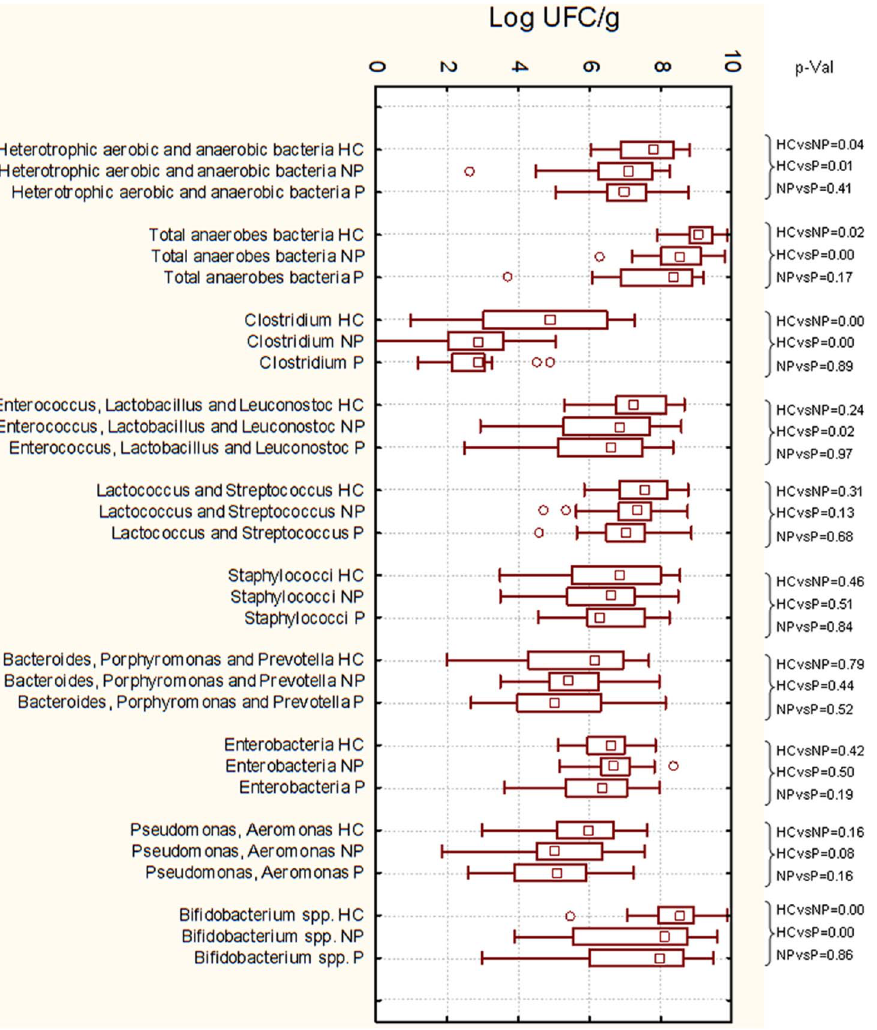
Figure 1. Fecal cultivable bacteria of the main microbial groups. Cultivable cells (log cfu/g) found in the fecal samples of immunoglobulin A nephropathy (IgAN) non progressor (NP) and progressor (P) patients, and healthy controls (HC). Data are the means of three independent experiments ( n =3). The top and bottom of the box represent the 75th and 25th percentile of the data, respectively. The top and bottom of the error bars represent the 5th and 95th percentile of the data, respectively. # , Outliers data. Group student’s t-test p-values were also shown.